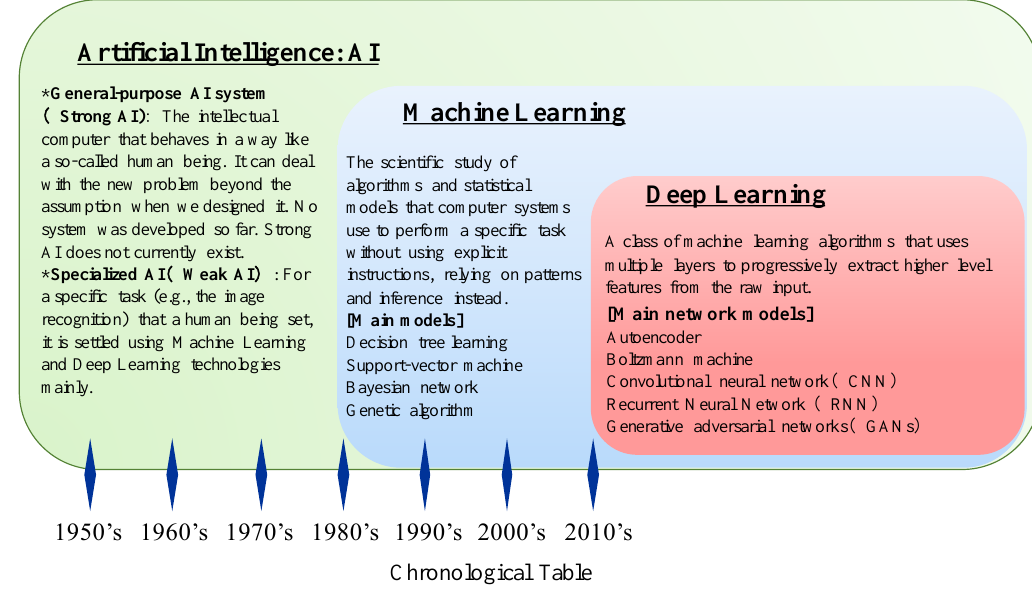
Figure 2. The summarized figure of artificial intelligence development.